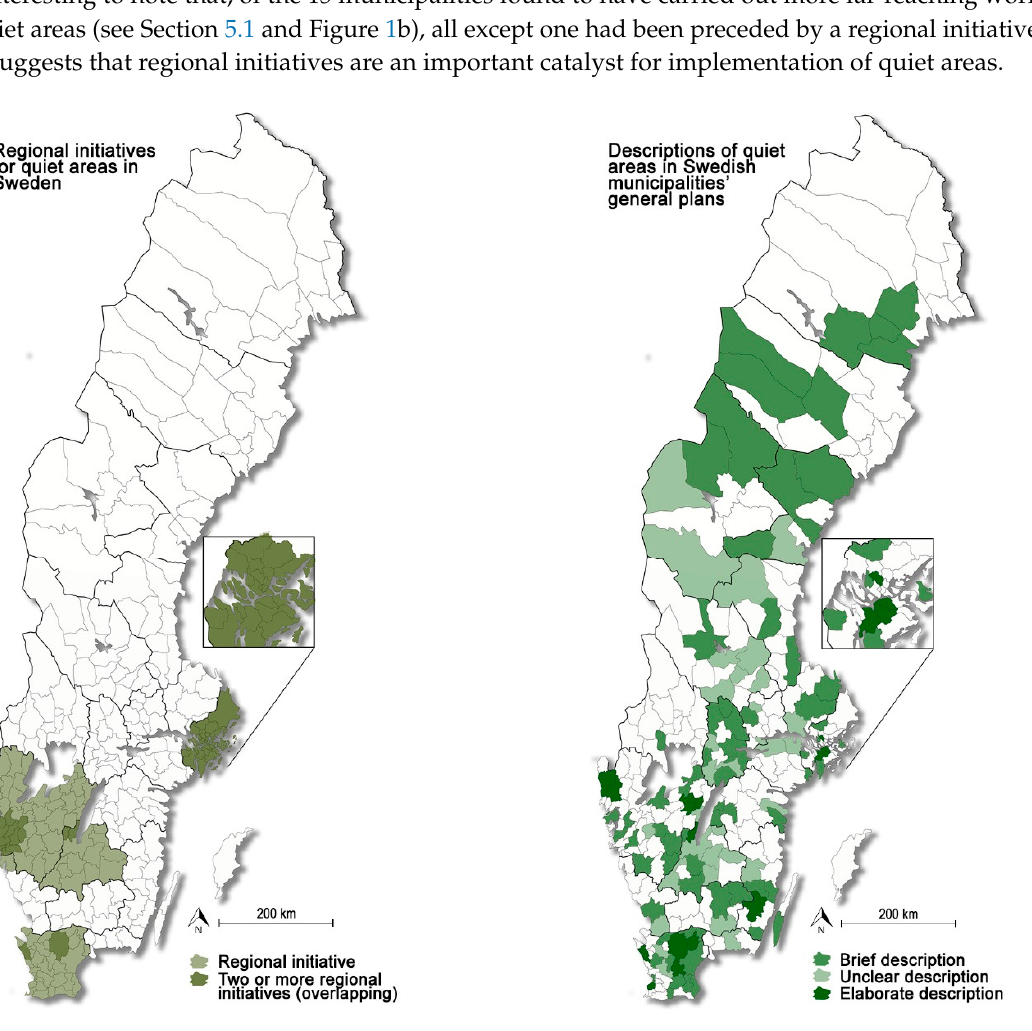
Figure 1. ( a ) Location of regional initiatives for quiet areas in Sweden. Overlapping initiatives are marked with darker color. ( b ) Location of municipalities that describe quiet areas in their general plans, with these descriptions divided into three categories: brief, unclear, and